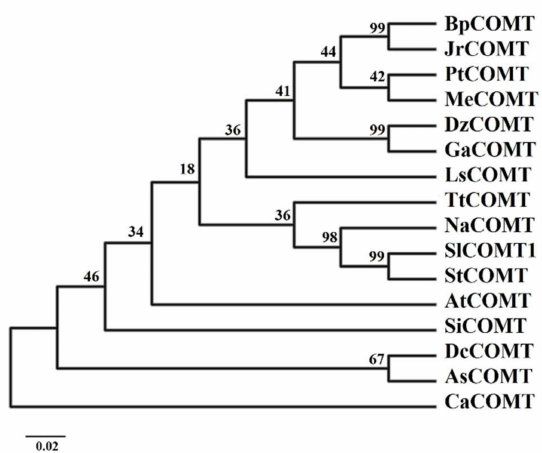
Figure 4. Phylogenetic analysis of the SlCOMT1 protein and its homologs. The proteins in the phylogenetic tree include Bp , Betula pendula (FJ667539.2); Jr , Juglans regia (XP_018828596.1); Pt , Populus Table 002321948. Me , Manihot esculenta (XP_021627291.1); Dz, Durio zibethinus